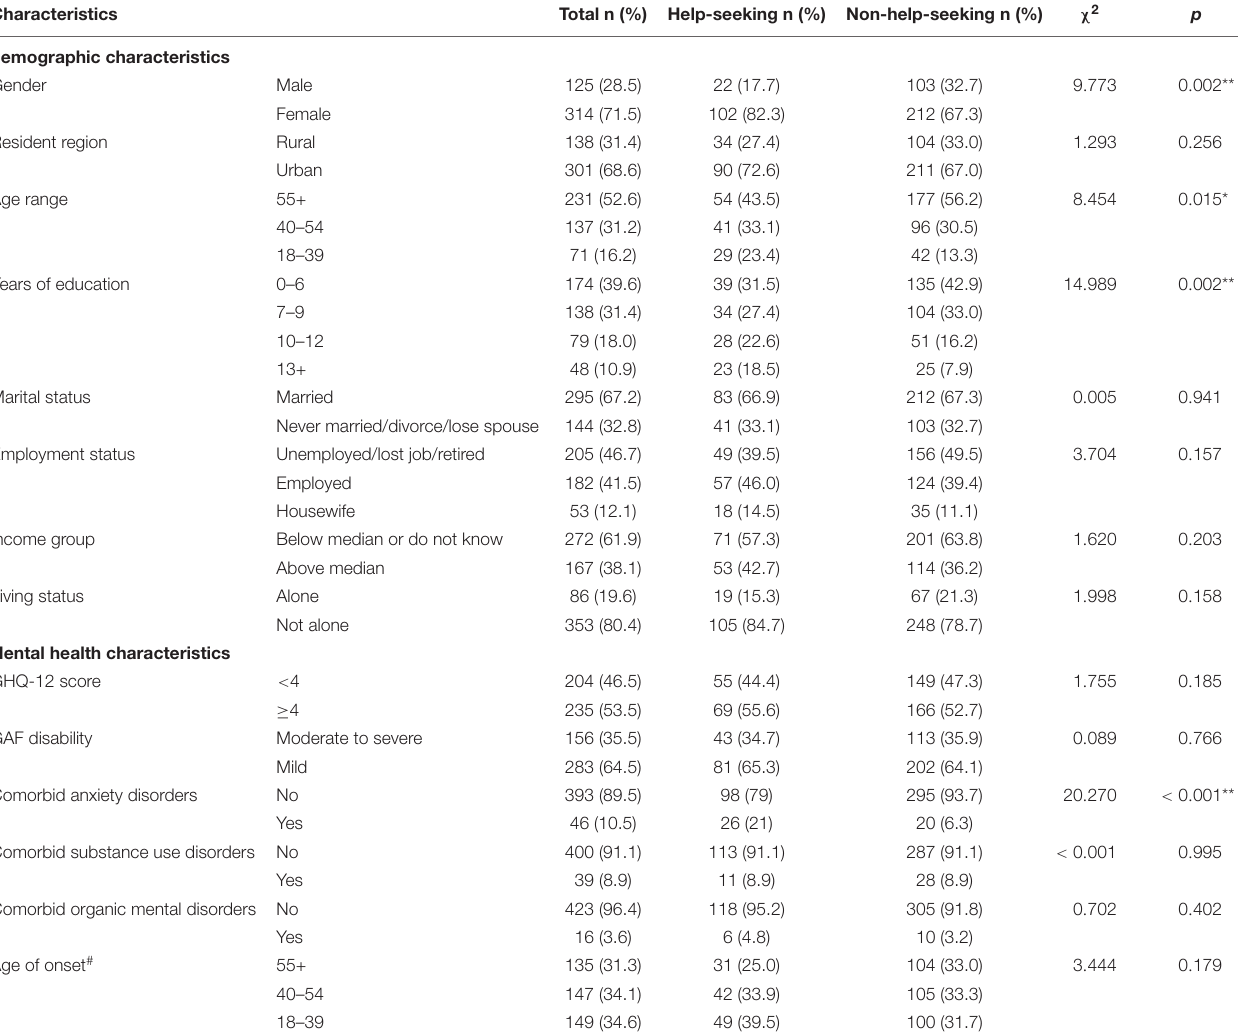
TABLE 1 | Characteristics for participants with MDD who did ( N = 124) and did not ( N = 315) seek help.